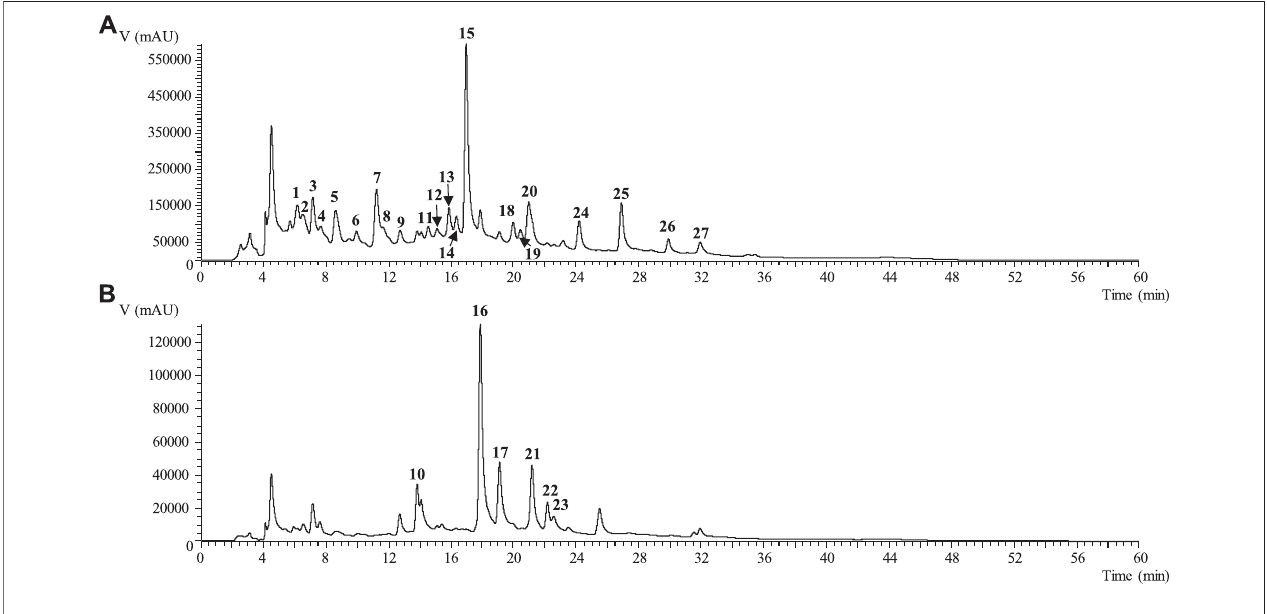
FIGURE 1 | Phenolic pro fi le of CSE recorded at 280 nm (A) and 370 nm (B) .